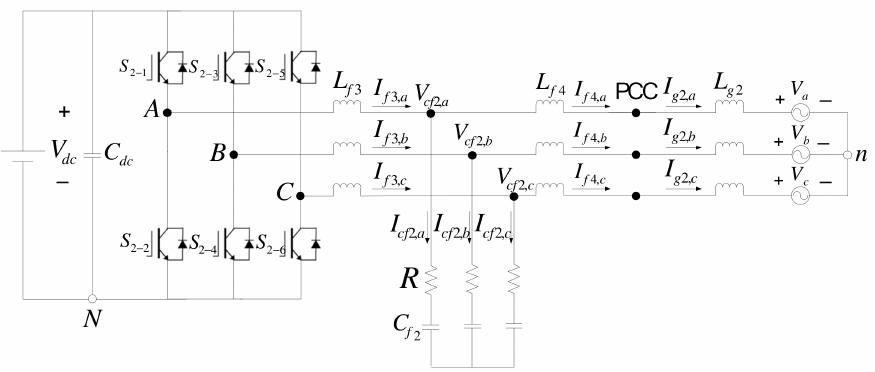
Figure 10. Configuration of the MG inverter.